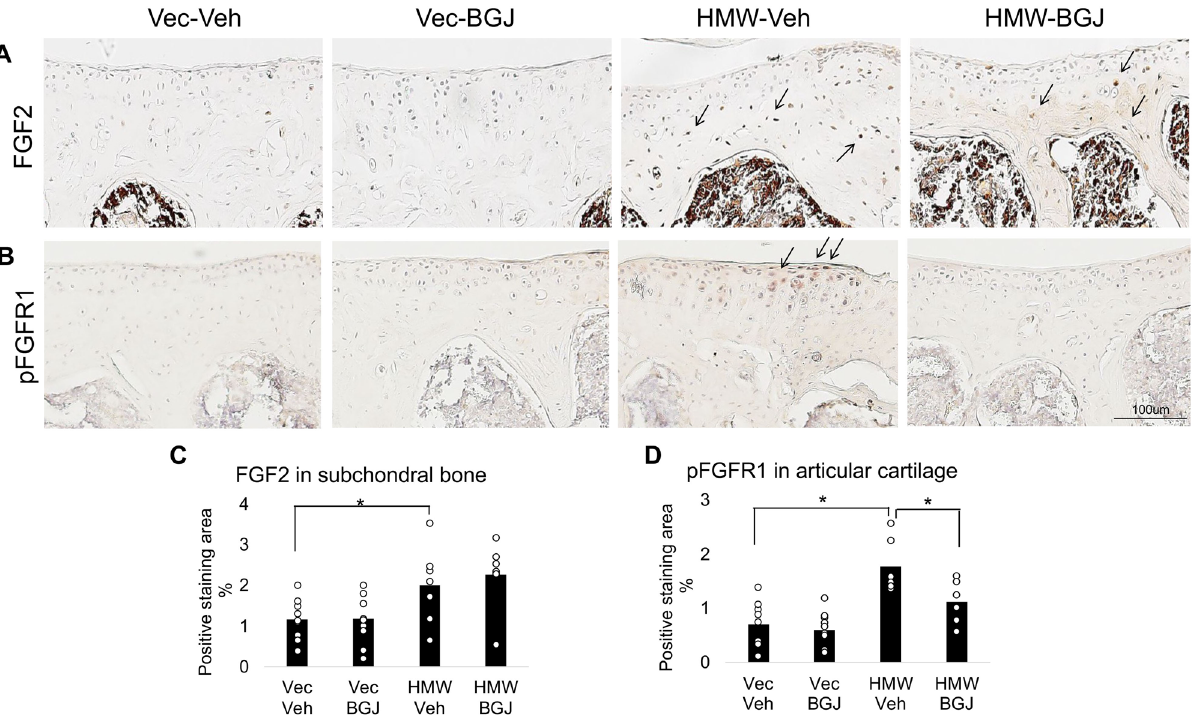
Figure 5. Expression of FGF2 in subchondral bone and phosphoFGFR1 in knee articular cartilage of 9.5-month-old Vector-Control and HMWTgFGF2 mice treated with BGJ398. Eight-month-old Vector-Control (Vec) and HMWTgFGF2 (HMW) female mice were sq injected with vehicle or BGJ398 5 days/week for 6 weeks. At the end of the experiment (9.5 months old), knee joints were collected for IHC staining. Representative immunohistochemical staining images for ( A ) FGF2 and ( B ) pFGFR1. Quantitative analysis of percentage of positive staining area for ( C ) FGF2 in subchondral bone and ( D ) pFGFR1 in articular cartilage. Data are shown as mean and individual points. n = 7–9 mice/group. *p < 0.05 by two-way ANOVA.